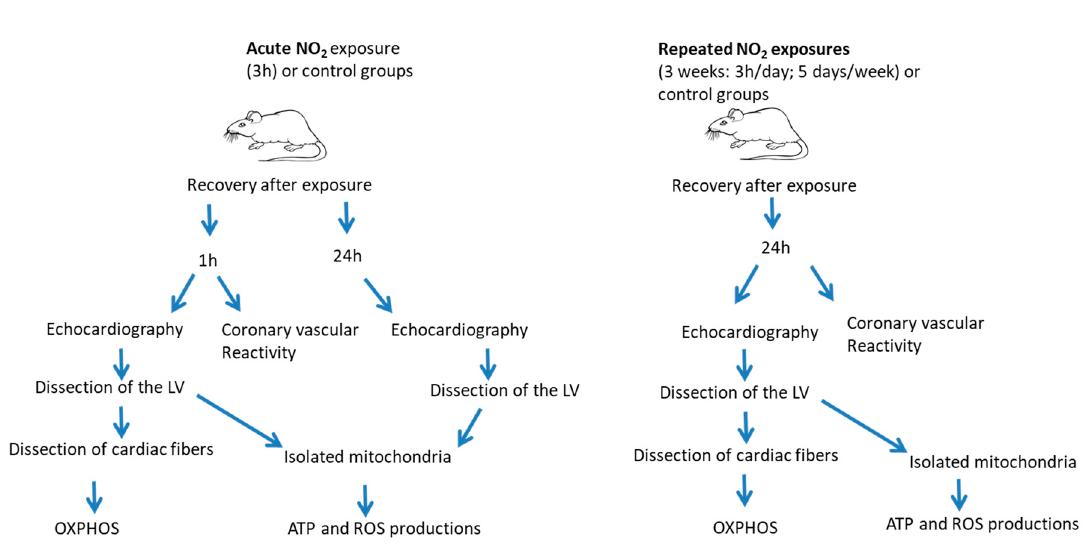
Figure 1. Experimental study design. LV: Left ventricle; OXPHOS: mitochondrial oxidative phosphorylation capacity; ROS: reactive oxygen species.